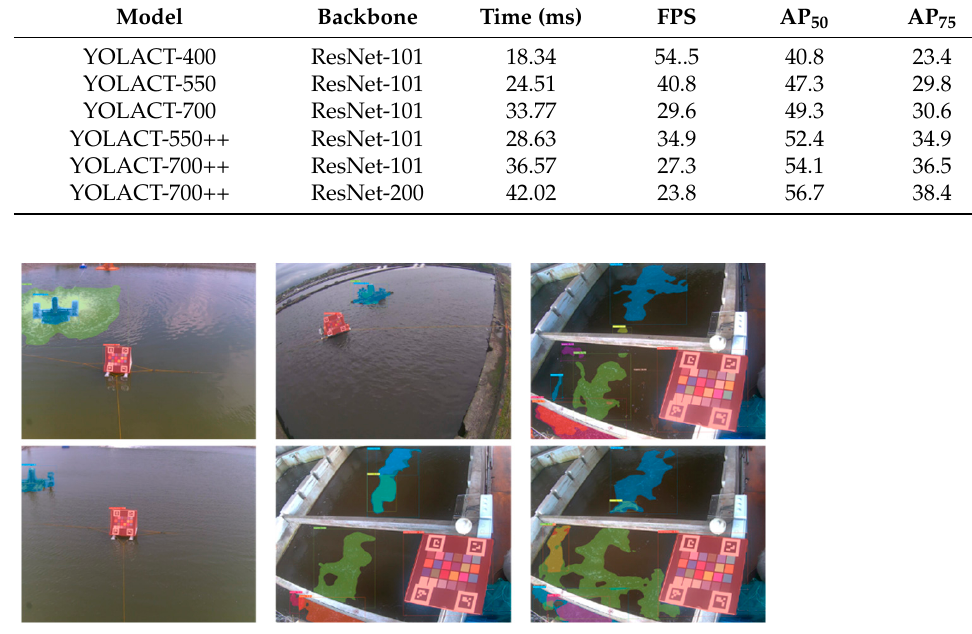
Table 5. The performance comparison among different settings of YOLCAT-based models.